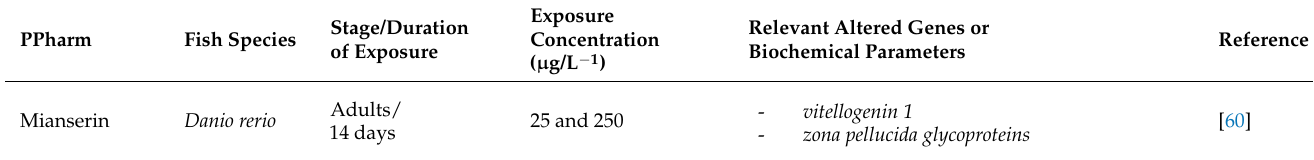
Table 2. Putative molecular and biochemical biomarkers of exposure to psychopharmaceuticals (PPharm). * identified through match with other organisms with sequences available in databases.